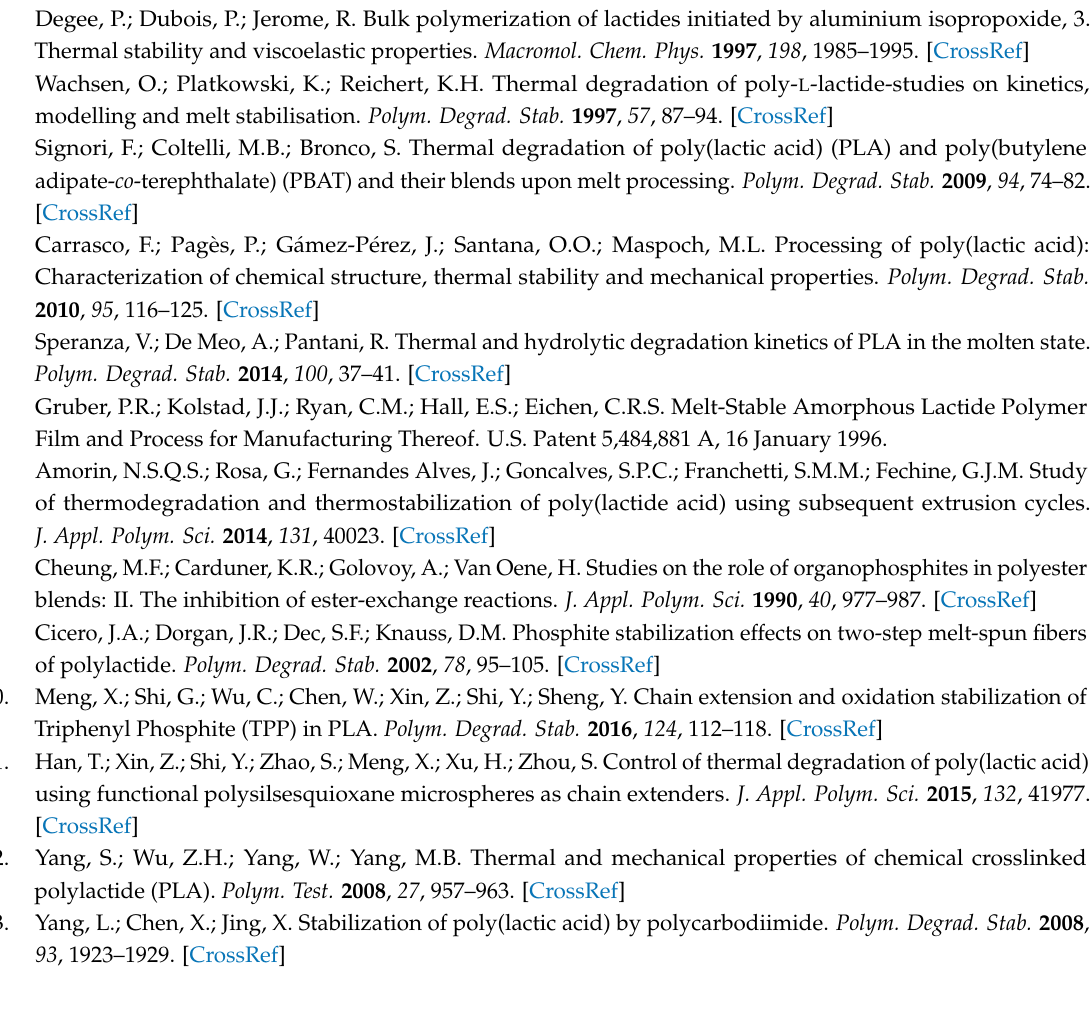
Figure S1: DSC heating scans of the extruded PLA and PLA compounded with 0.1wt % of HSAG, LSAG and